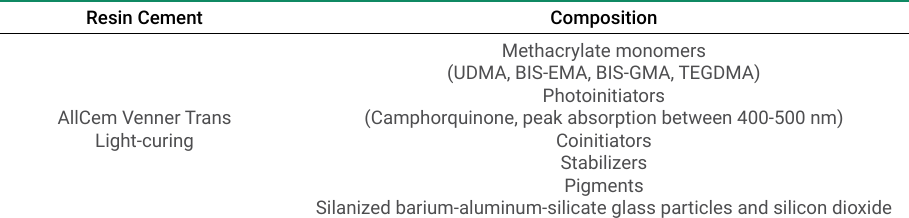
Table 1. The composition of the light-curing resin cement AllCem Venner Trans (FGM, Dentscare LTDA, Joinville-SC, Brazil) Resin